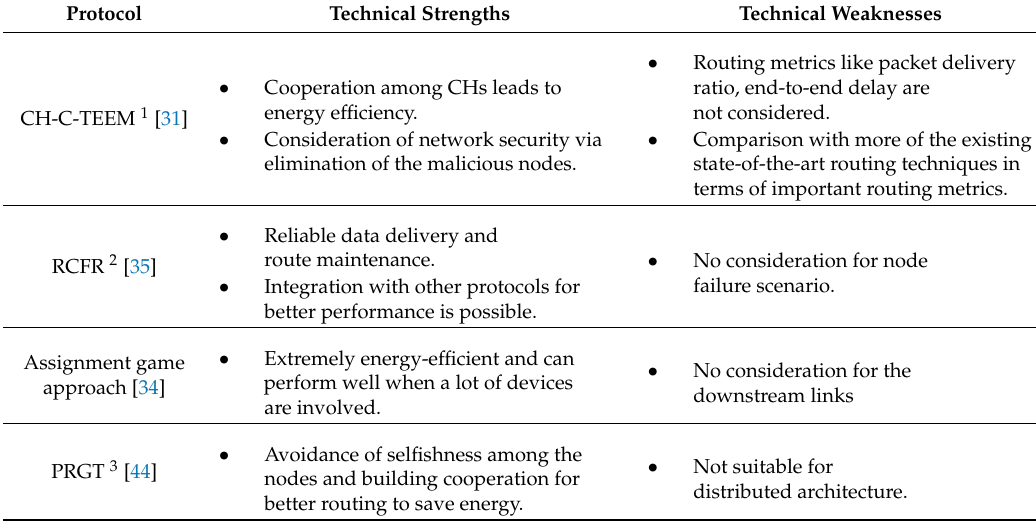
Table 4. Comparison of routing protocols based on cooperative games in terms of technical strengths and